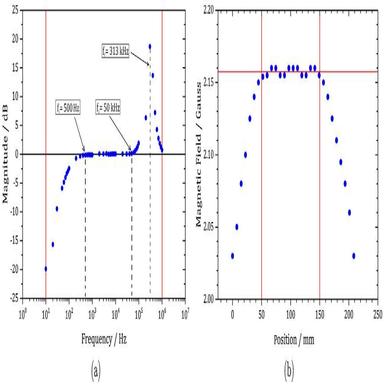
(a) The frequency response of the Helmholtz coils – waveform generator circuit, (b) magnetic field along the axis crossing the center of the Helmholtz coils.